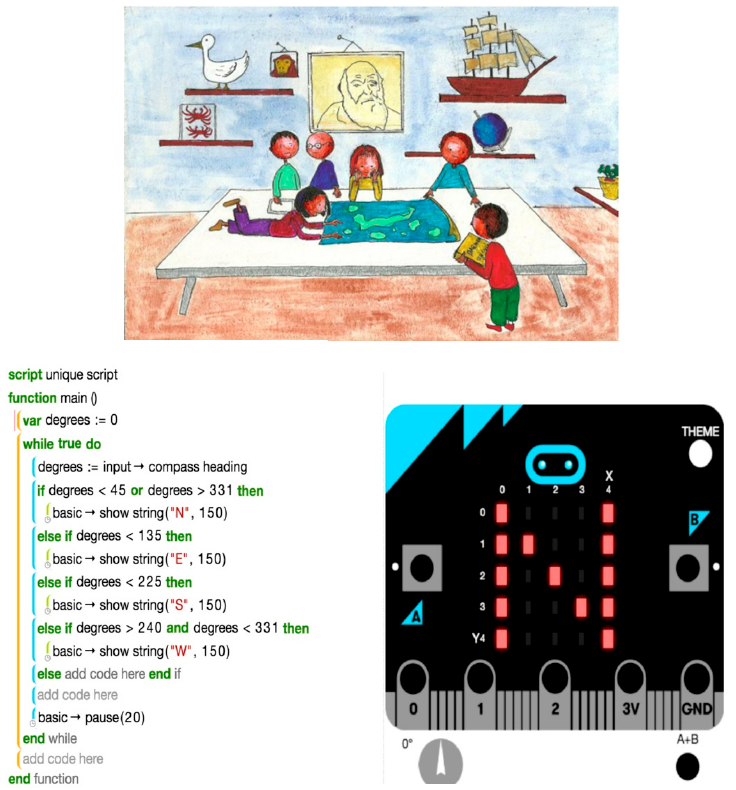
Figure 6. From tangible artefact, to virtual, to physical for sharing (design: year 7 students). 5.